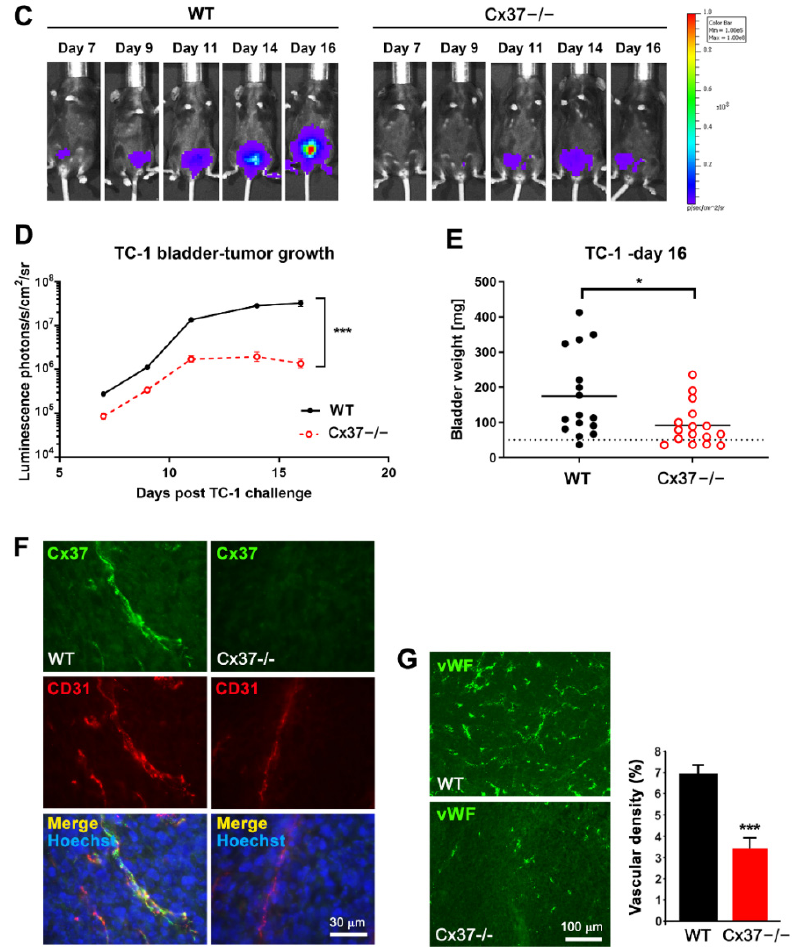
Figure 5. Loss of Cx37 decreases the vascularization and growth of TC-1 tumors established in the bladder. ( A ) Immunostaining showed Cx37 (green) in the CD31-positive EC (red) of control bladders. Representative images are shown at low (bar = 50 µ m) and high magnification (bar = 20 µ m) in the top and bottom row, respectively. Cell nuclei are seen after Hoechst staining (blue). ( B ) Immunostaining of native bladder sections for Von Willebrand factor (vWF, top panel), overlaid with Evan’s blue counterstain (bright field, BF, bottom panel), revealed many blood vessels, mainly localized within the lamina propria of the bladder (LP; L= lumen; M: muscular layers). Quantitative evaluation showed that the volume density of these vessels was similar in the bladders of WT and Cx37 − / − mice. Data are mean + SEM values of 3 fields, photographed from 3 mice per group. ( C ) Representative bioluminescence imaging of TC-1-luc tumors growing in the bladder of a WT (left) and a Cx37 − / − mouse (right). ( D ) The mean + SEM bioluminescence intensity (photons/sec/cm2/sr) of the TC-1 tumors growing in the bladder of WT mice (black line, n = 16) was significantly higher than that of the tumors growing in the bladder of Cx37 − / − mice (red line, n = 16). *** p < 0.001 versus WT mice (Student’s t -test on the area under the tumor growth curve). ( E ) Sixteen days after the intravesical instillation of TC-1 cells, the combined weight of bladders and growing tumors was measured and found to be significantly higher in WT than Cx37 − / − mice. Horizontal lines show mean values. The dotted line shows the mean weight of native mice bladders. * p < 0.05 versus WT mice (Student’s t -test). ( F ) Immunostaining showed the presence of Cx37 on CD31-positive EC of TC-1-luc tumors grown in the bladders of WT (left) but not of Cx37 − / − mice (right). ( G ) After 16 days, the immunostaining for von Willebrand factor (vWF) revealed that the vessel density of TC-1-luc tumors was higher in Cx37 − / − than WT mice. Data are mean + SEM of 5–7 areas from tumors of similar size, which developed in 5 different mice per group. *** p < 0.001 versus WT mice (Student’s t